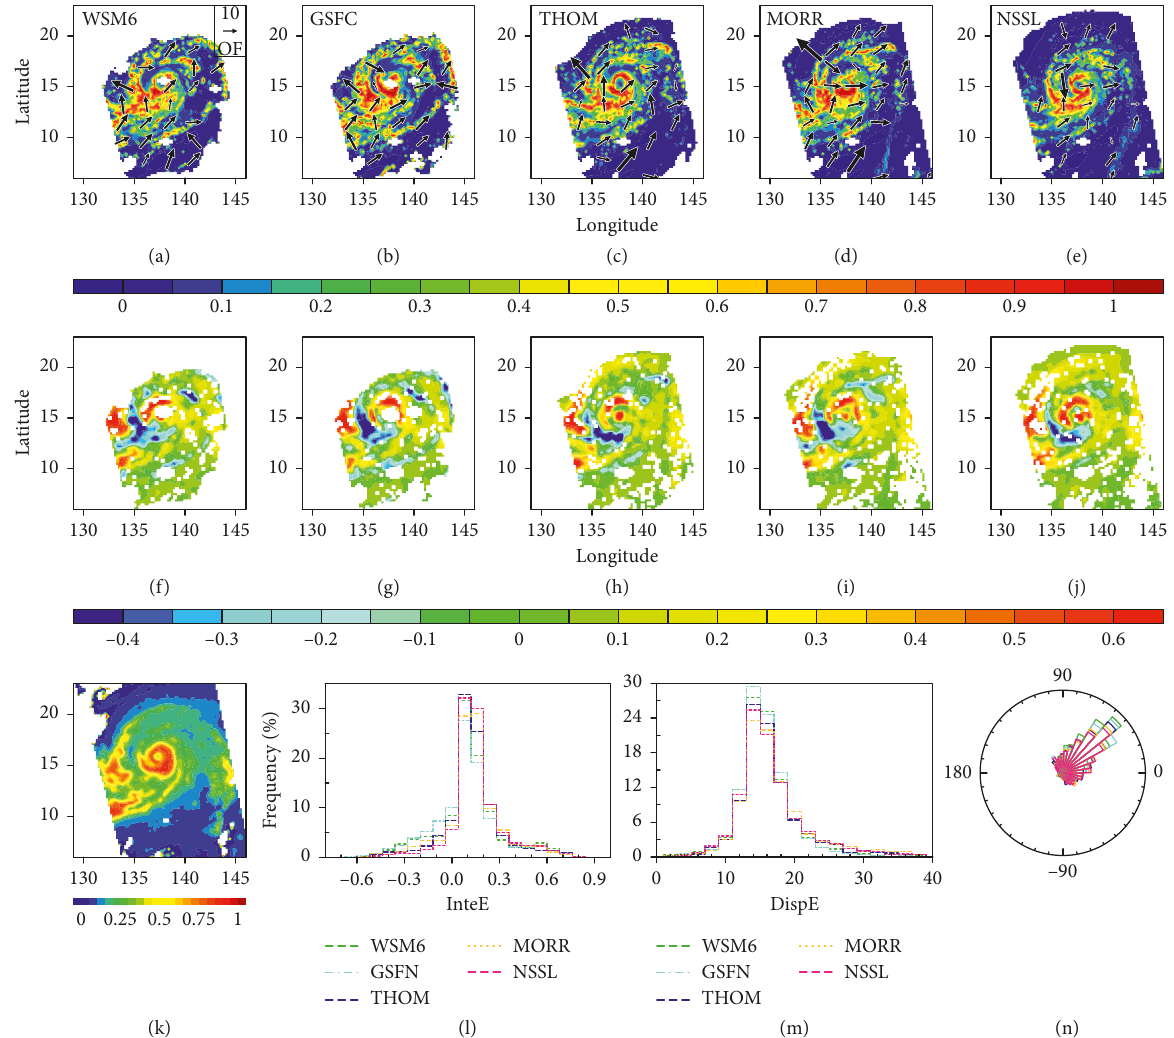
Figure 7: The OF field and the three components of error in the five simulated fields for the EI index. (a) ∼ (e) The spatial distribution of the emission index (EI) field: (a) WSM6, (b) GSFC, (c) THOM, (d) MORR, and (e) NSSL; the overlaid OF field (arrows) mapping the simulated to (k) the observed EI field. The spatial distribution of intensity error (f) WSM6, (g) GSFC, (h) THOM, (i) MORR, and (j) NSSL and histogram of the three components of the simulation error of (l) intensity error (InteE), (m) displacement error (DispE), and (n) angular error. See text for